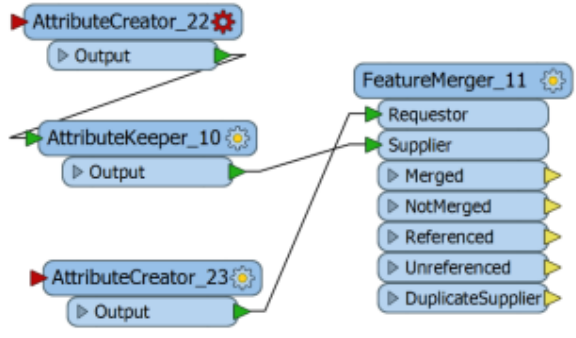
Figure 6: Connection between the Openings and the Surfaces